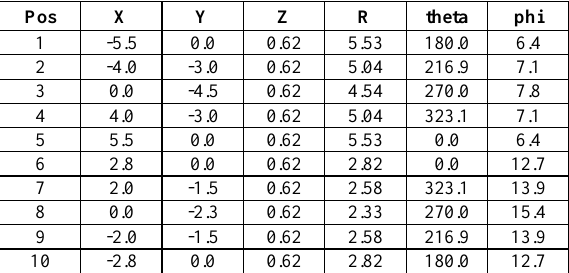
Table 2. Coordinates and angles for ten positions of flash light. The green channel was extracted from each of the registered images. All monochrome images (16-bit linear) were then scaled by finding the 99.5 th percentile value from the